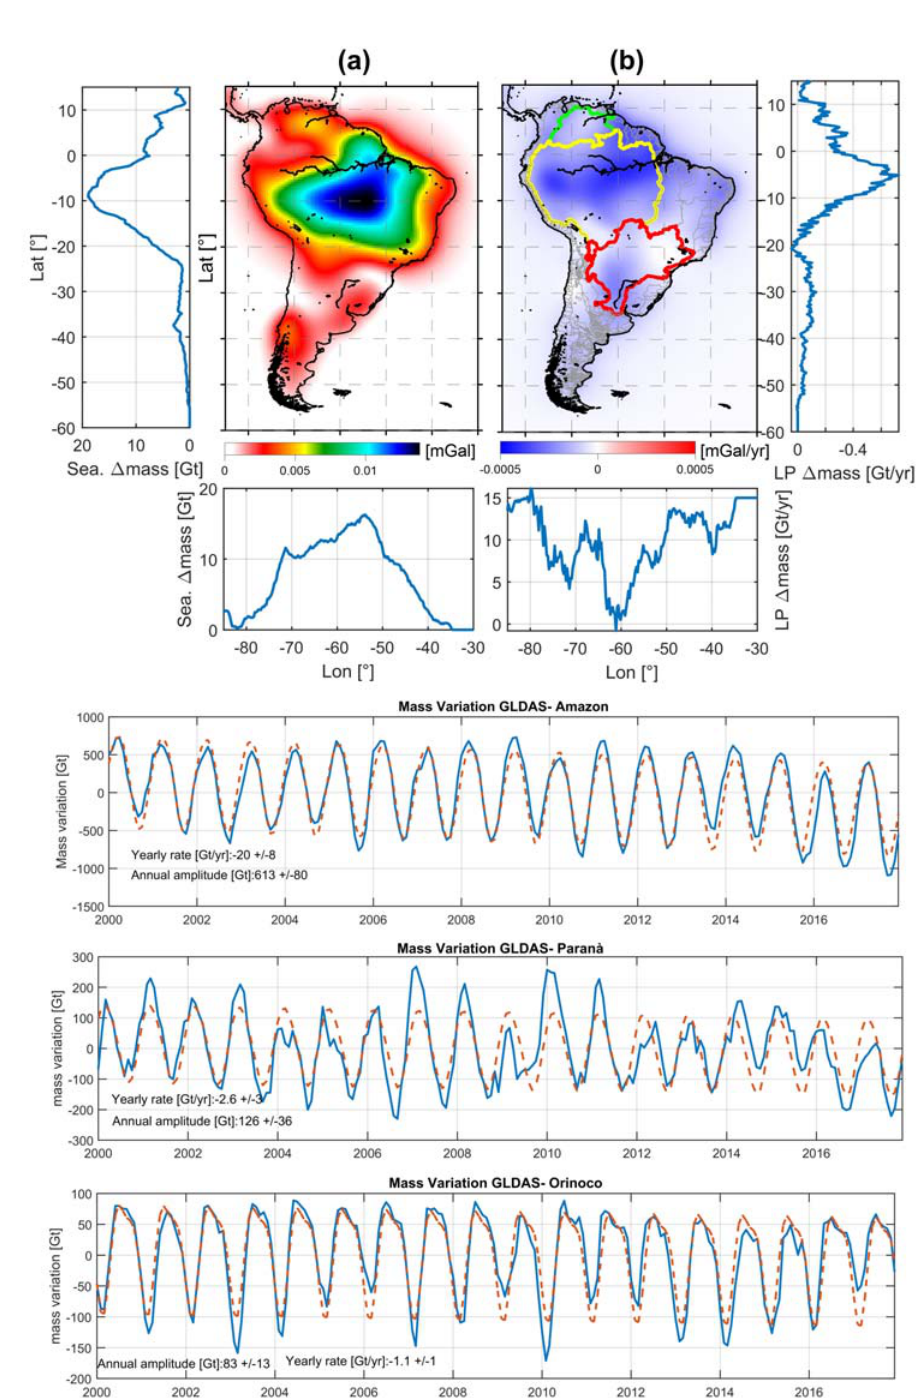
Figure 3. ( a ) Amplitude signal of the GLDAS for South America. ( b ) Long period (LP) gravity signal of the GLDAS model; colored lines report the outlines of the Paraná (red), Amazon (yellow), and Orinoco (green) basins. Plots on the side and bottom report for both the maps the seasonal and LP hydrologic mass changes as functions of longitude and latitude. Central plot: long-period signal according to GLDAS for the Amazon basin; top right: seasonal annual amplitude of the Amazon. Bottom plot reports the time-series of the mass variations of the Orinoco, Amazon, and Paraná basins. Blue curve = observed mass variations for GLDAS; red curve = fitted mass variations of the basin with Equation (1).